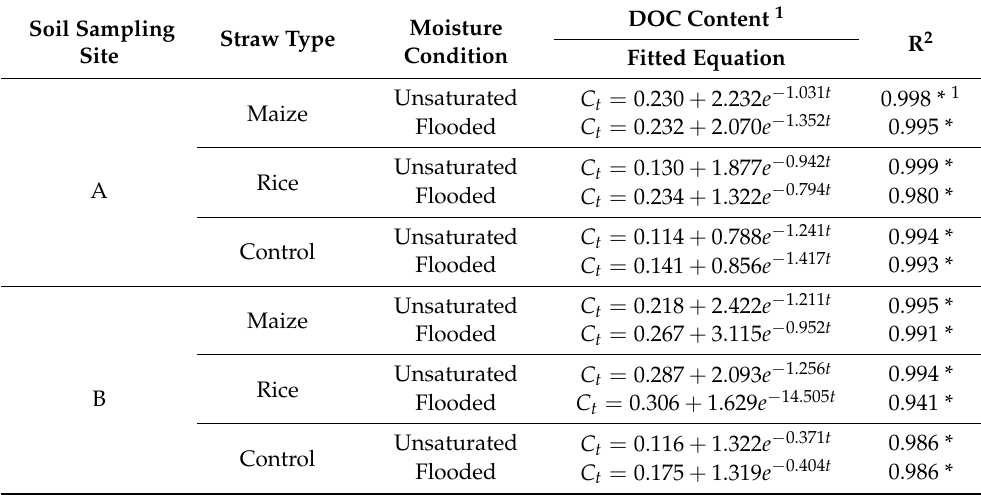
Figure 2. Temporal changes of dissolved organic matter content (represented by dissolved organic carbon (DOC)) in the soils collected from sites A ( a ) and B ( b ) during laboratory incubation with/without straw addition under flooded/unsaturated conditions. The Y ordinate is logarithmi- cally transformed (log2). Table 1. Fitted equations to the laboratory incubation experimental data of temporal changes of soil DOM content.